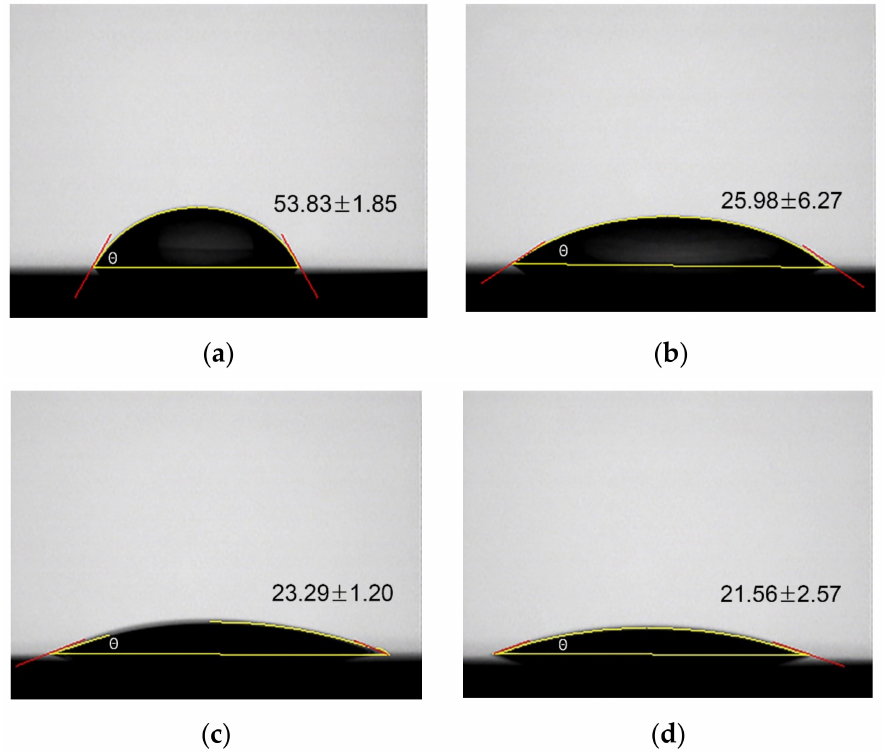
Figure 5. Water contact angle of specimens. ( a ) control group, ( b ) 60 s group, ( c ) 120 s group, ( d ) 180 s